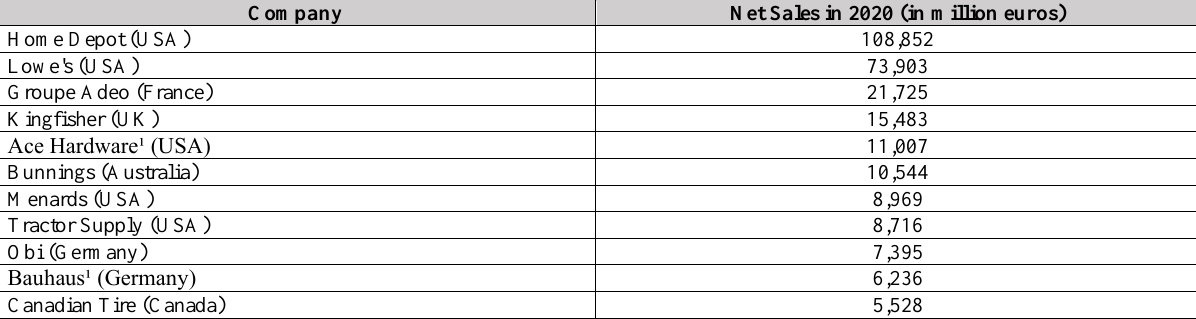
Table 2. Leading DIY Stores Worldwide in Terms of Net Sales in